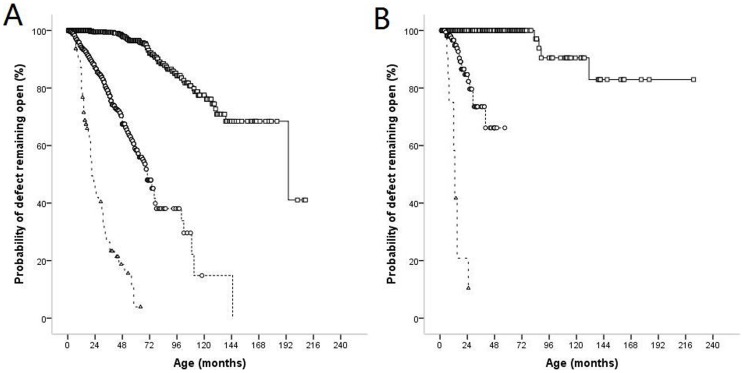
Comparison among PMVSD patients of high probability(△), intermediate probably(○) and low probability(□) occurring SC by Kaplan-Meier's method.A: Probability of defect remaining open in the deviation cohort (p<0.001). B: Probability of defect remaining open in the validation cohort (p<0.001).